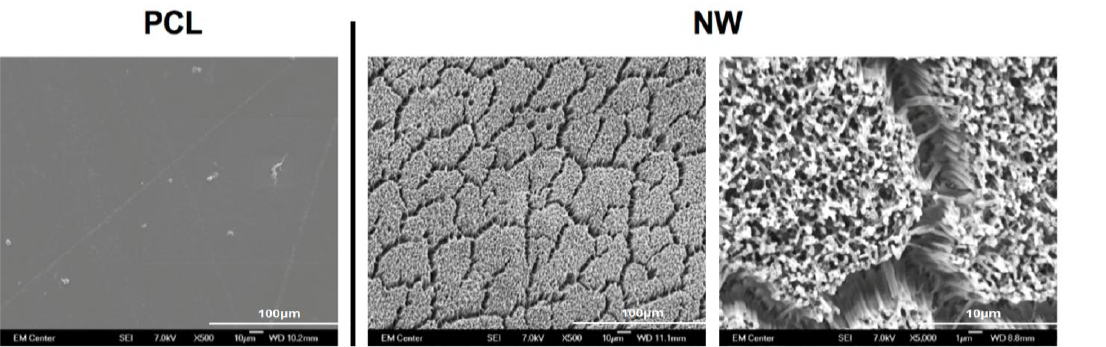
Figure 1. Representative SEM images of polycaprolactone discs (PCL) and polycaprolactone nanowire surfaces (NW). The high magnification SEM images of NW show the nanoarchitecture as well as presence of randomized microchannels.